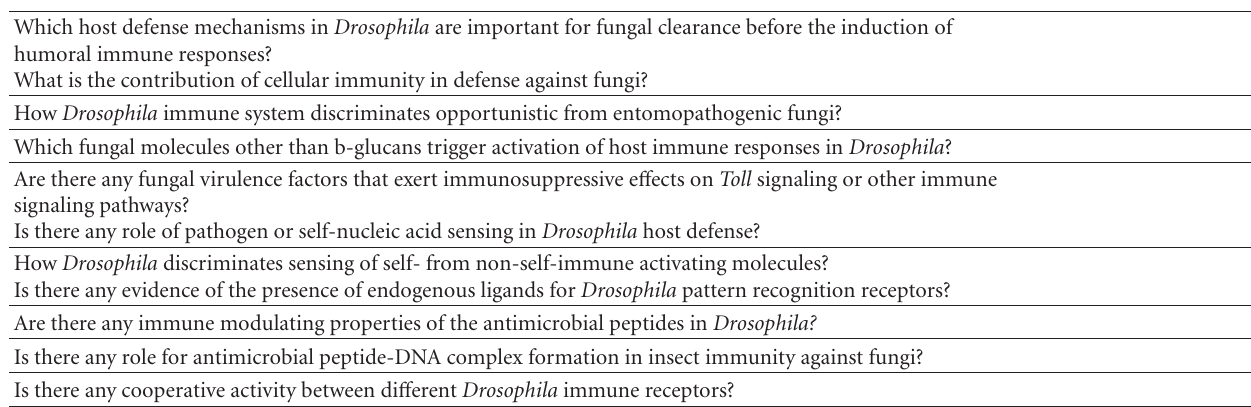
Table 1: Important research questions on antifungal immunity in Drosophila